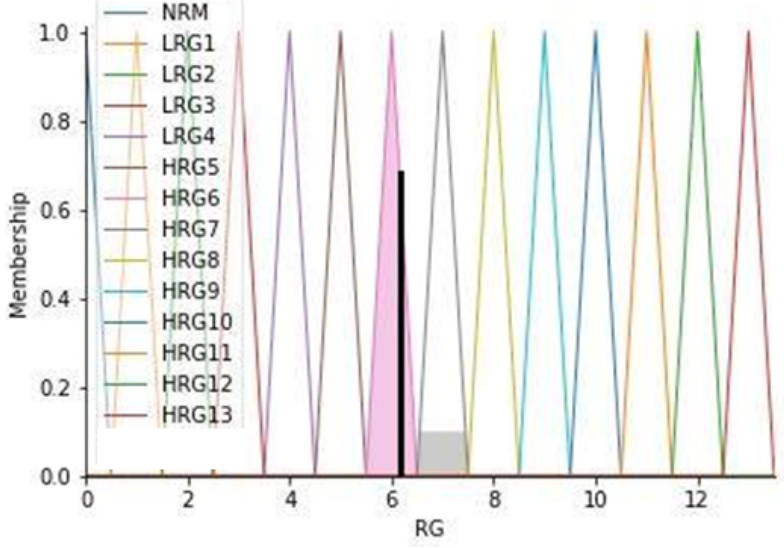
Figure 11. Results display for case study 2.